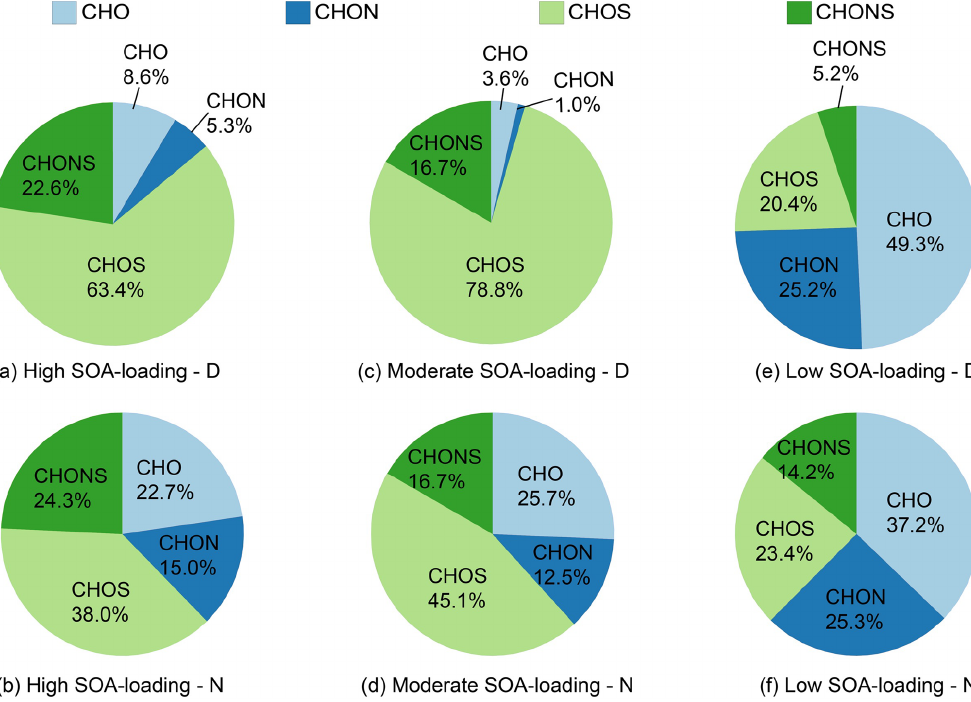
https://doi.org/10.5194/acp-23-2061-2023 Atmos. Chem. Phys., 23, 2061–2077,